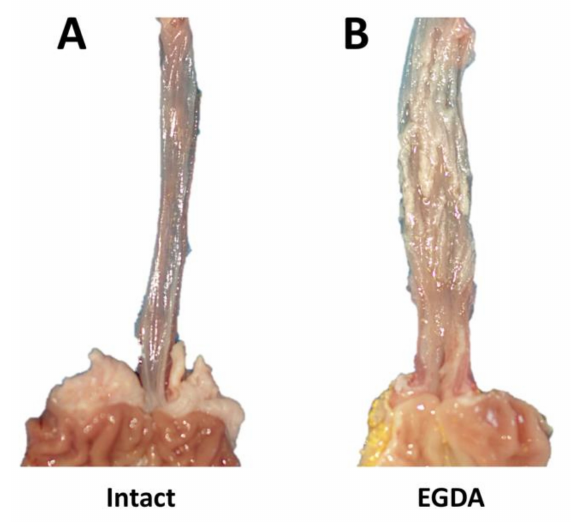
Figure 6. Macroscopic appearance of esophageal mucosa, gastroesophageal junction and gastric cardia in representative rats without (Intact, A ) or with esophagogastroduodenal anastomosis (EGDA, B ).